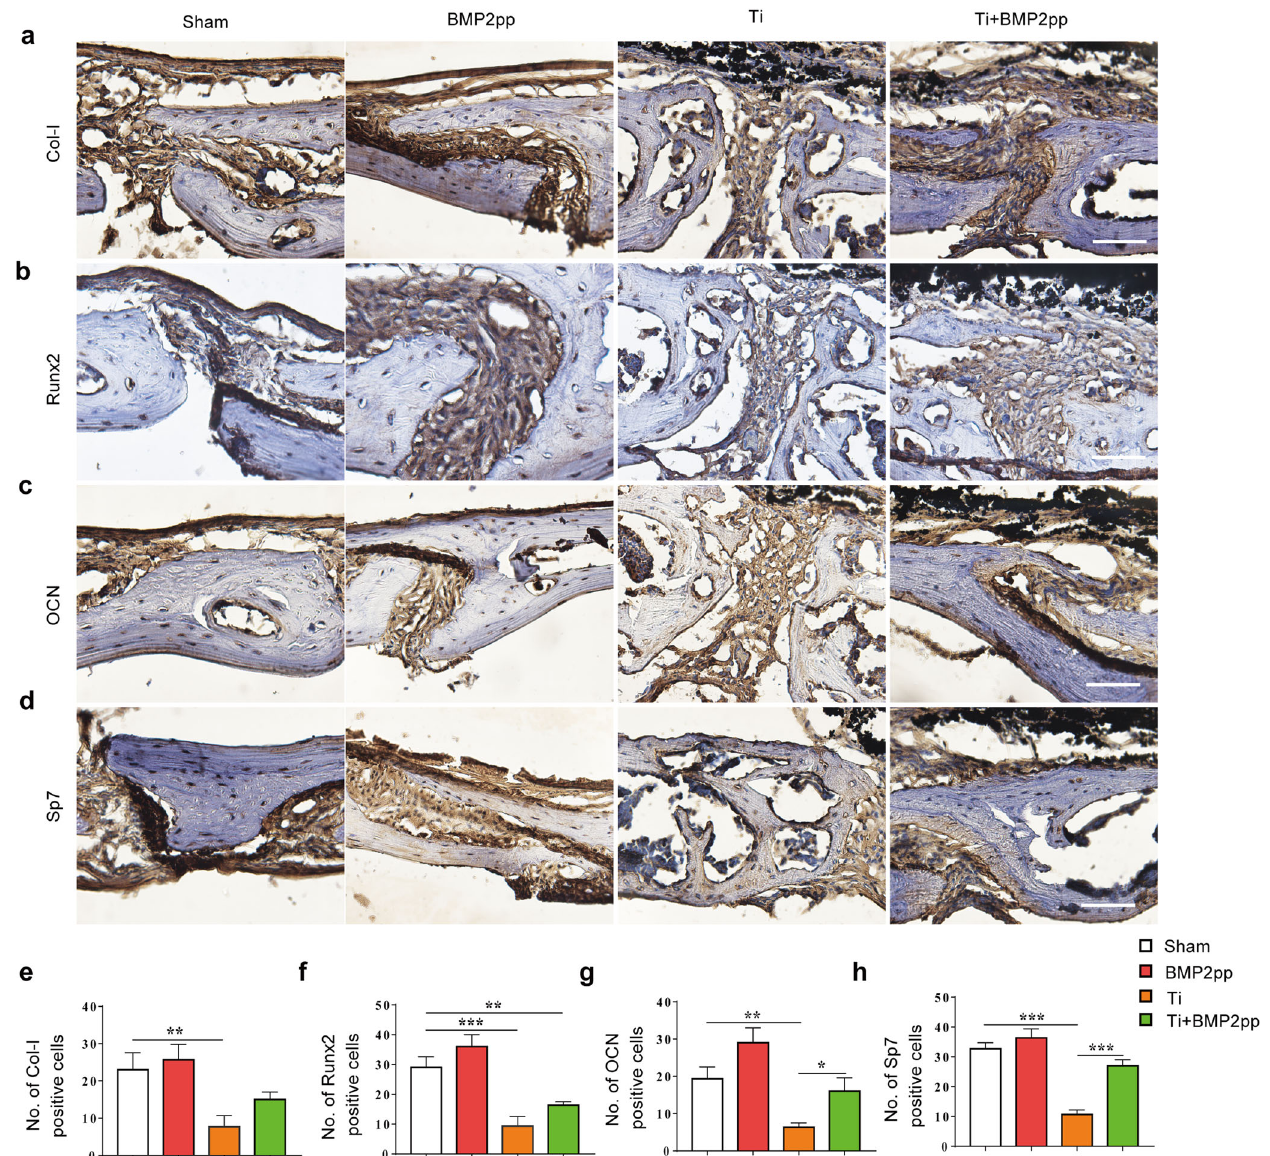
Fig. 5 BMP2pp enhanced the calvarial bone formation impaired by Ti particles in mice. Representative images of a Col-I, b Runx2, c OCN, and d Sp7 immunohistochemical staining of calvarial bone. scale bars: 50 μ m. Number of e Col-I, f Runx2, g OCN, and h Sp7 staining positive cells, n = 8. All the data are presented as the average ± standard deviation